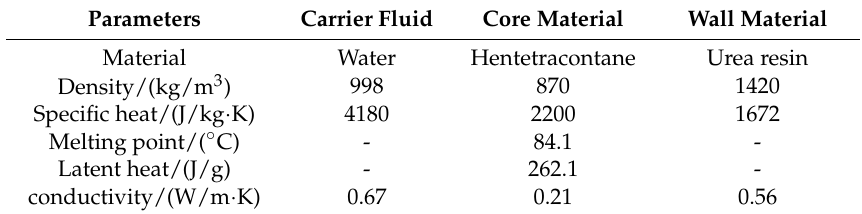
Table 1. Thermal and physical properties of the microencapsulated phase change material slurry (MPCMS).